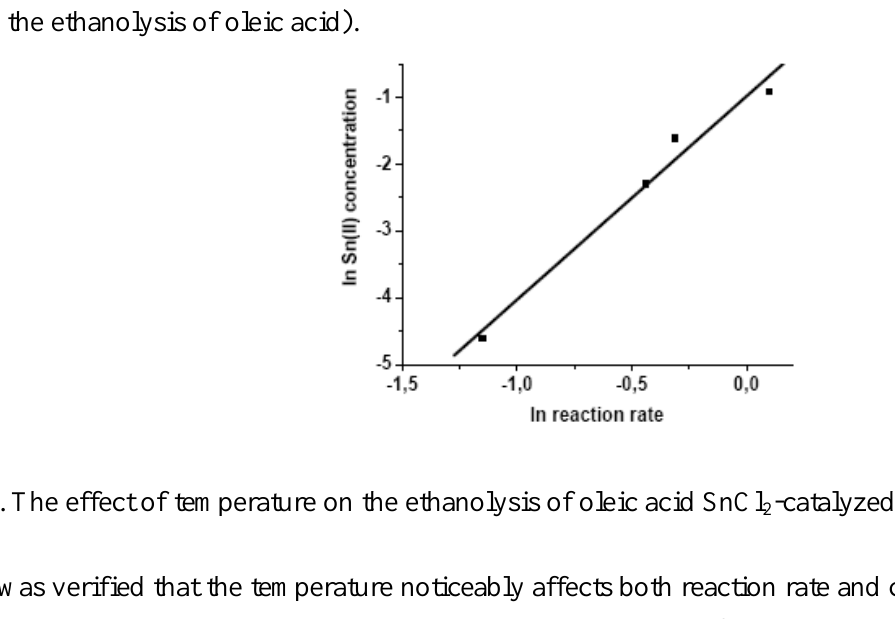
] (effect of the concentration of SnCl 2